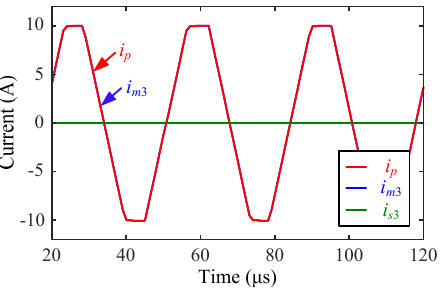
Figure 8. Current transformer of the third output module under open − circuit condition.